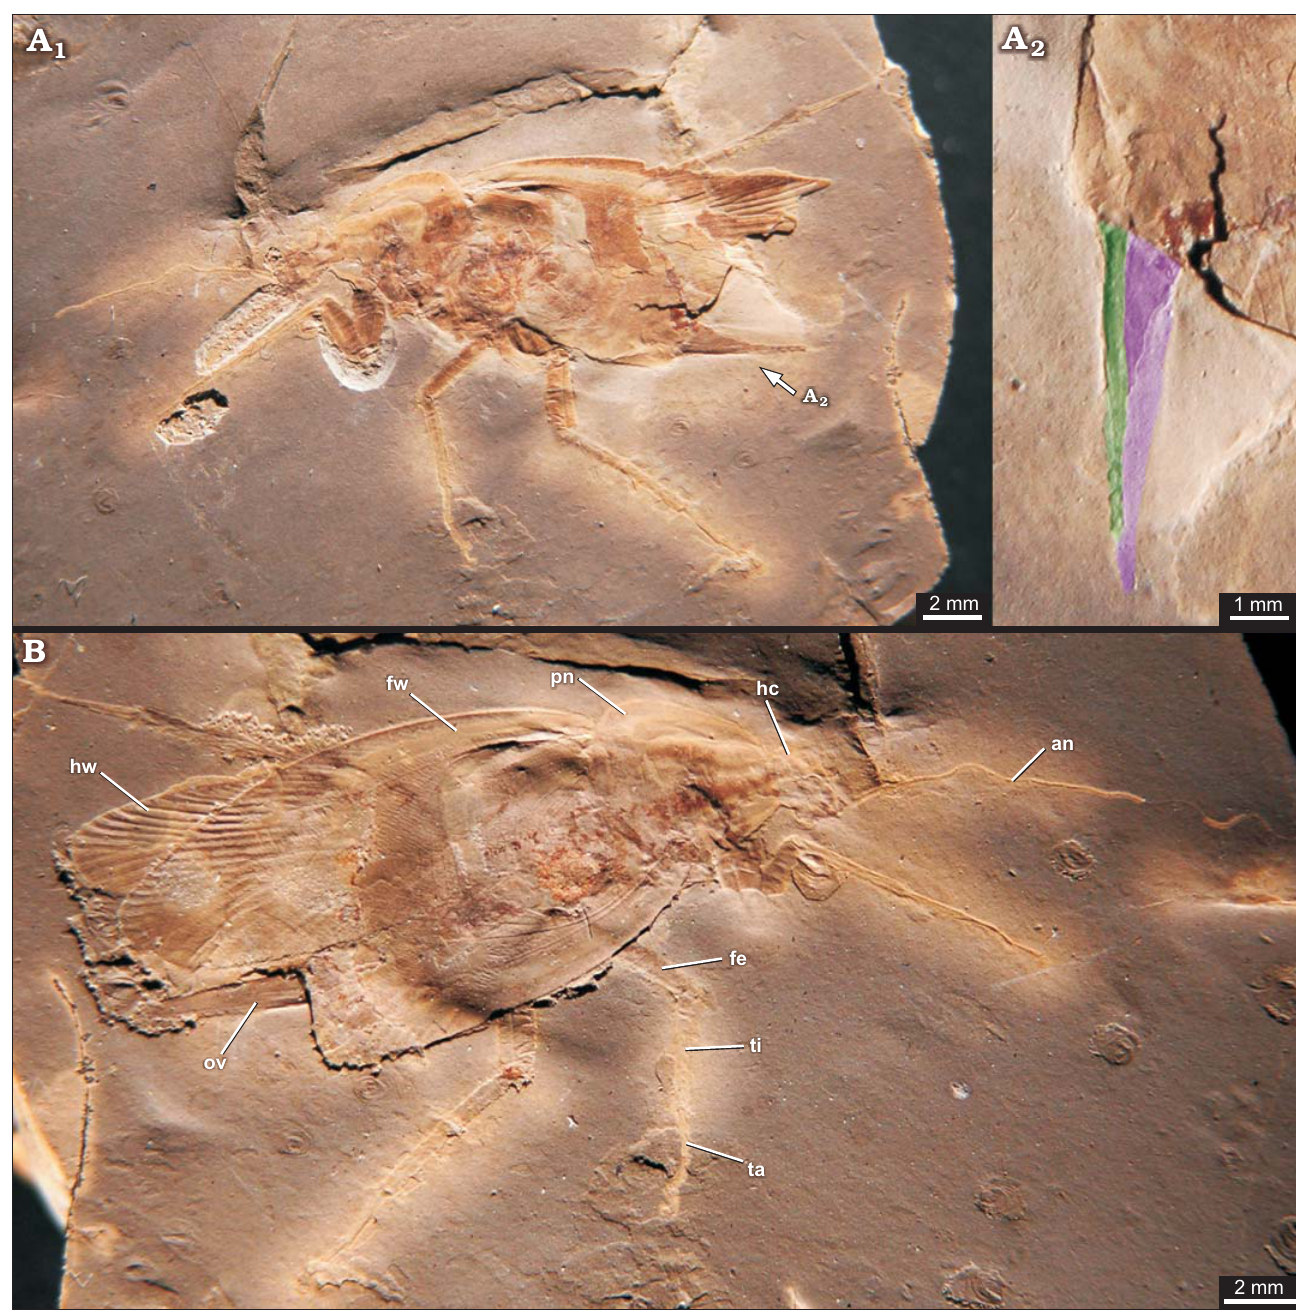
Fig. 9. Roachoid Syscioblatta sp. from early Permian of Obora, Czech Republic; in dorsal view. A . Part KUP 114a. B . Counterpart KUP 114b. A 1 , B, overviews; A 2 , close-up of the ovipositor (green, valve 1; purple, valve 3). Abbreviations: an, antenna; fe, femur of prothoracic leg; fw, fore wing; hc, head capsule; hw, hind wing; ov, ovipositor; ta, tarsus of prothoracic leg; ti, tibia of prothoracic